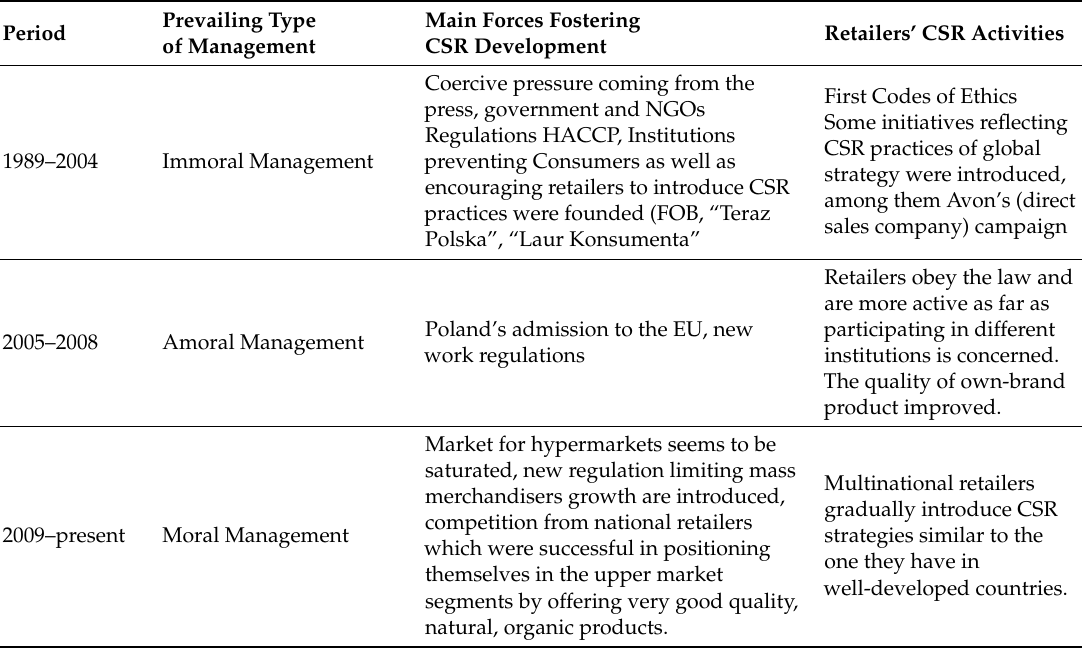
Table 2. Stages of CSR towards consumer